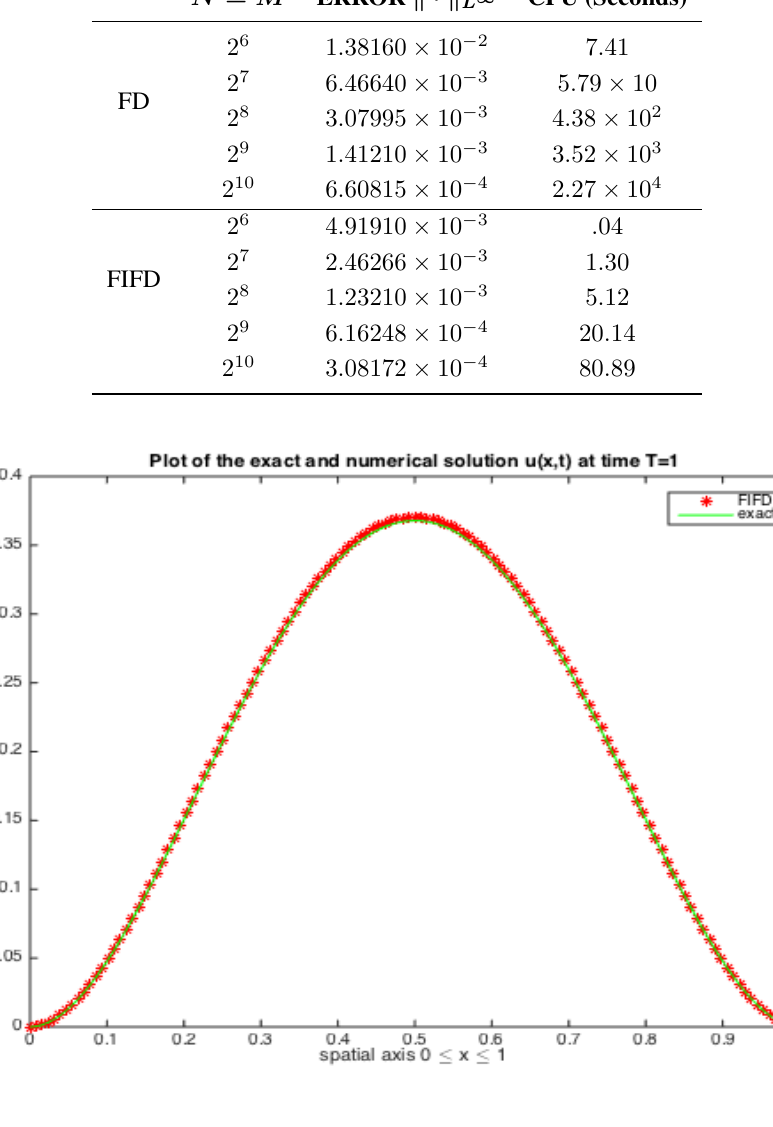
and ∆ t = 1 128 128